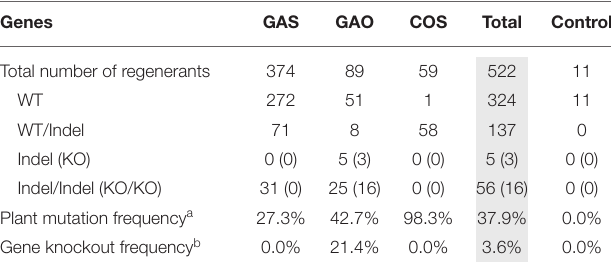
TABLE 5 | Overview of the mutation events in the pCDB-Cas9-GAS, pCDB-Cas9-GAO, and pCDB-Cas9-COS protoplast transfected and regenerated plants.